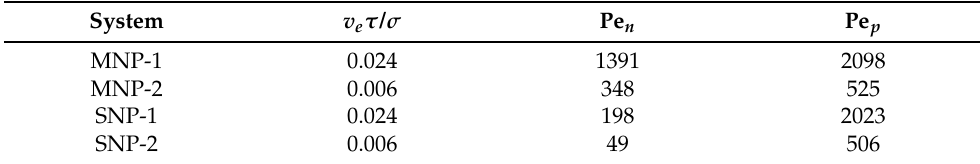
Table 1. Péclet numbers for all polymer-nanoparticle mixtures